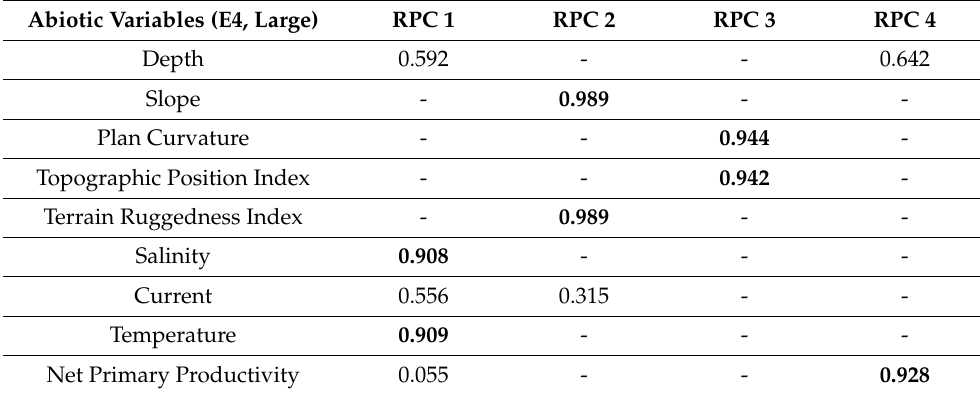
Table 5. Rotated components matrix. Correlation between the original input variables and the Varimax rotated principal components for the larger study area using four eigenvalues. Values with r > 0.7 or r < − 0.7, are considered high factor loads (bold), while low factor loads (r < 0.3 or r > − 0.3) are omitted.